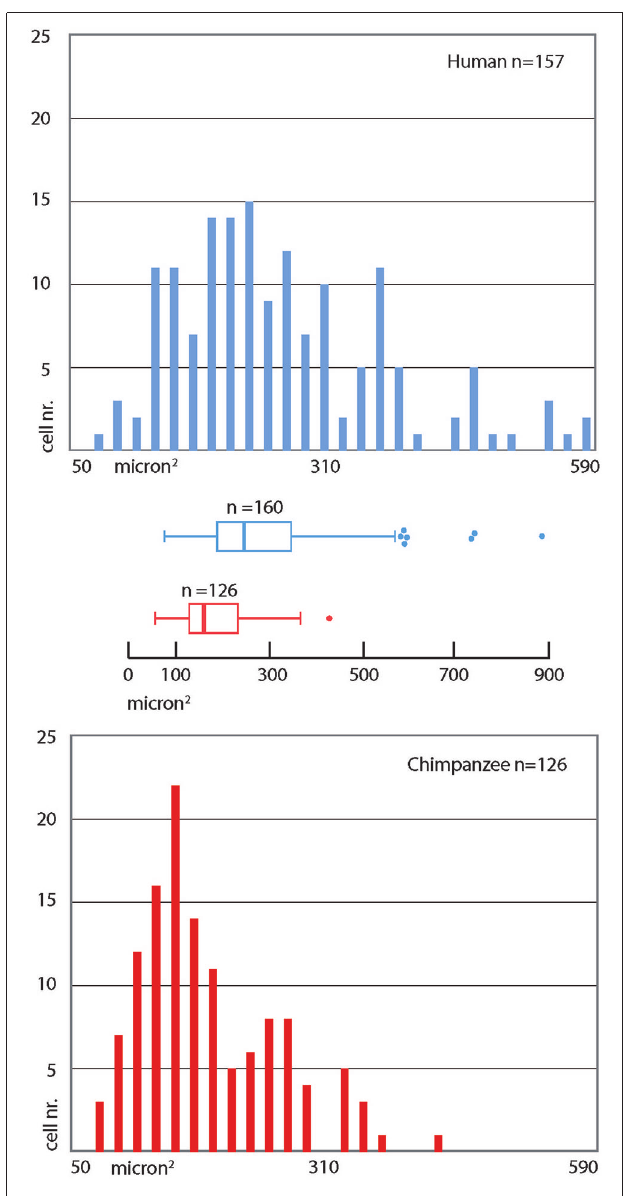
FIGURE 6 | Frequency distribution of cross-section areas of PV immunoreactive neurons in the human and chimpanzee claustrum . Bins = 20 µ m 2 . The box in the box plot shows the median and interquartile range. Left whiskers include low extreme values; the length of right whiskers is interquartile range ×